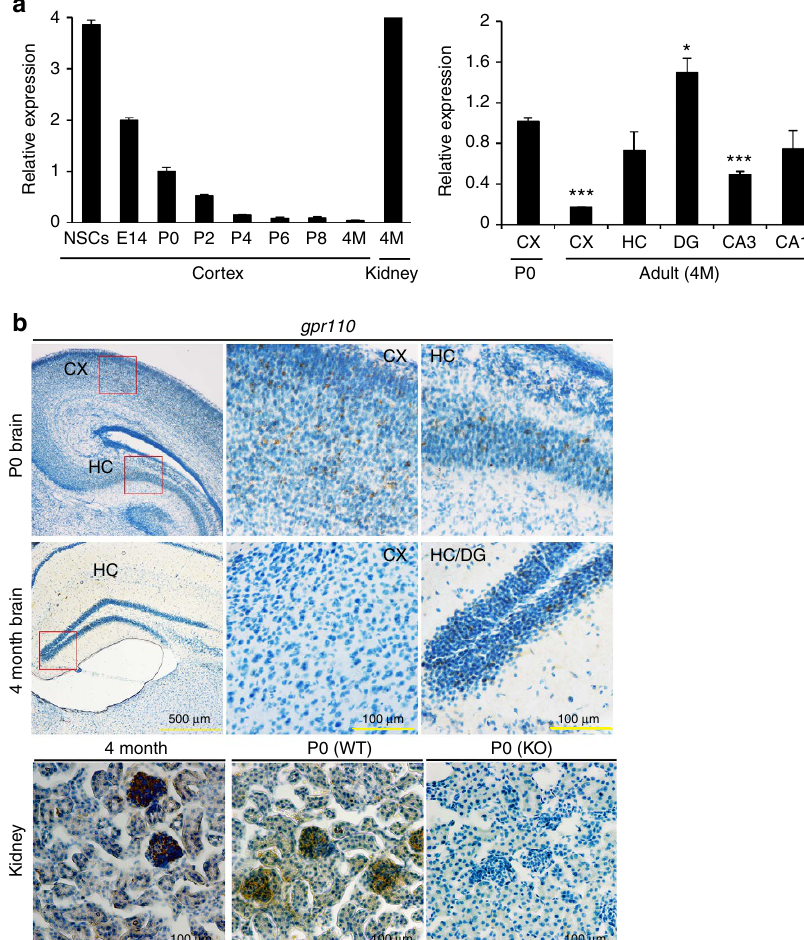
Figure 6 | Expression of gpr 110 transcripts in the mouse brain. Temporal and regional expression of GPR110 mRNA evaluated by quantitative real-time PCR indicated high expression in NSCs and fetal brain (FB) as well as in hippocampus (HC), particularly the dentate gyrus (DG) area, in 4 month (4M) old adult brains ( a ). The expression was normalized to the level in the P0 cortex ( b ). In situ hybridization also indicated the considerable expression of gpr 110 in P0 brain cortex and hippocampus as wells as adult hippocampal DG area while adult cortical region showed rare expression ( b ). Coronal sections of newborn and adult mouse brains are shown. The boxed areas in the micrographs on the far left panels are shown at a higher magnification for CX and HC regions in the two right panels. Nuclei were counterstained with hematoxylin. Positive staining is indicated by the high expression in glomeruli of P0 and adult kidney. The P0 kidney from KO mouse was used as a negative control. CX, cerebral cortex. Data represent three ( a ) or five ( b ) independent experiments. Data in a are means ± s.e.m. of biological triplicates ( n ¼ 3). * P o 0.05, *** P o 0.001 by unpaired Student t -test versus newborn (P0)